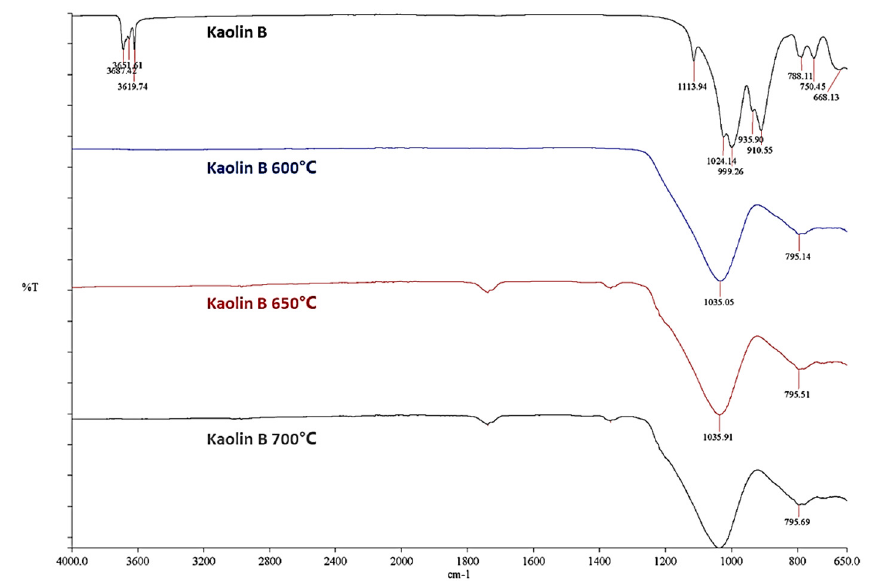
Figure 6. FTIR spectra of Kaolin B and its calcined products at 600, 650 and 700 °C.